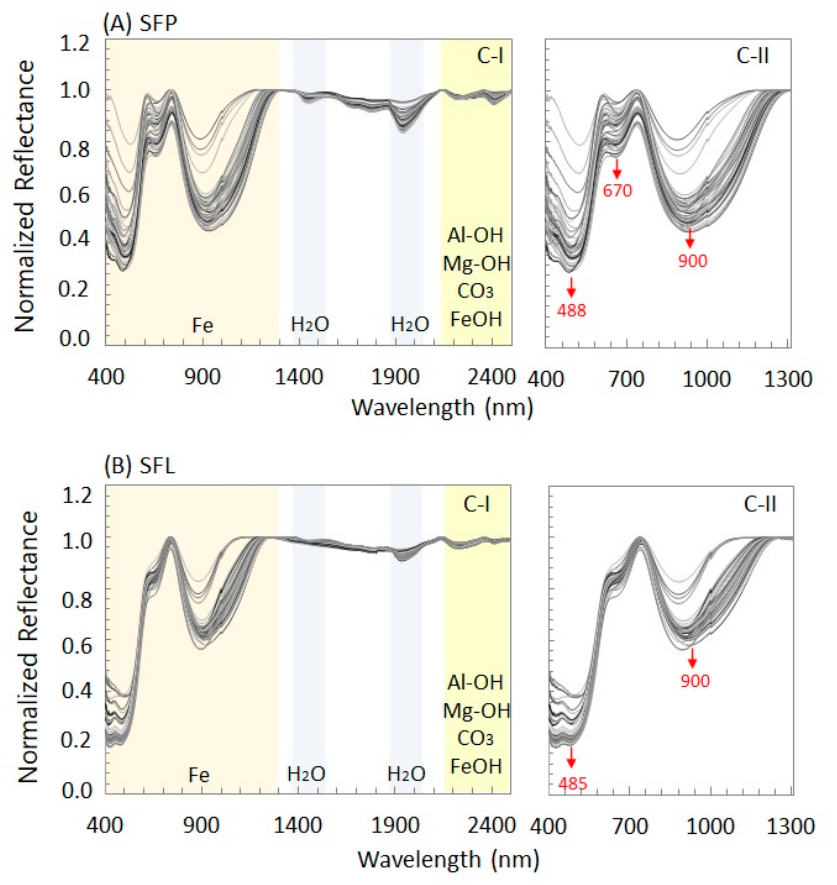
Figure 4. Reflectance spectra normalized by removal of the continuum from the samples used in model training: ( A ) Spectra obtained in the SFP samples, showing the database used for C-I and C-II; ( B ) Mean of the SFL spectra used for C-I and C-II. The absorption bands relevant to the study are highlighted in the spectra. SFP—Sinter Feed Product; SFL—Sinter Feed prepared in the laboratory; C-I—Calibration 1; C-II—Calibration 2.